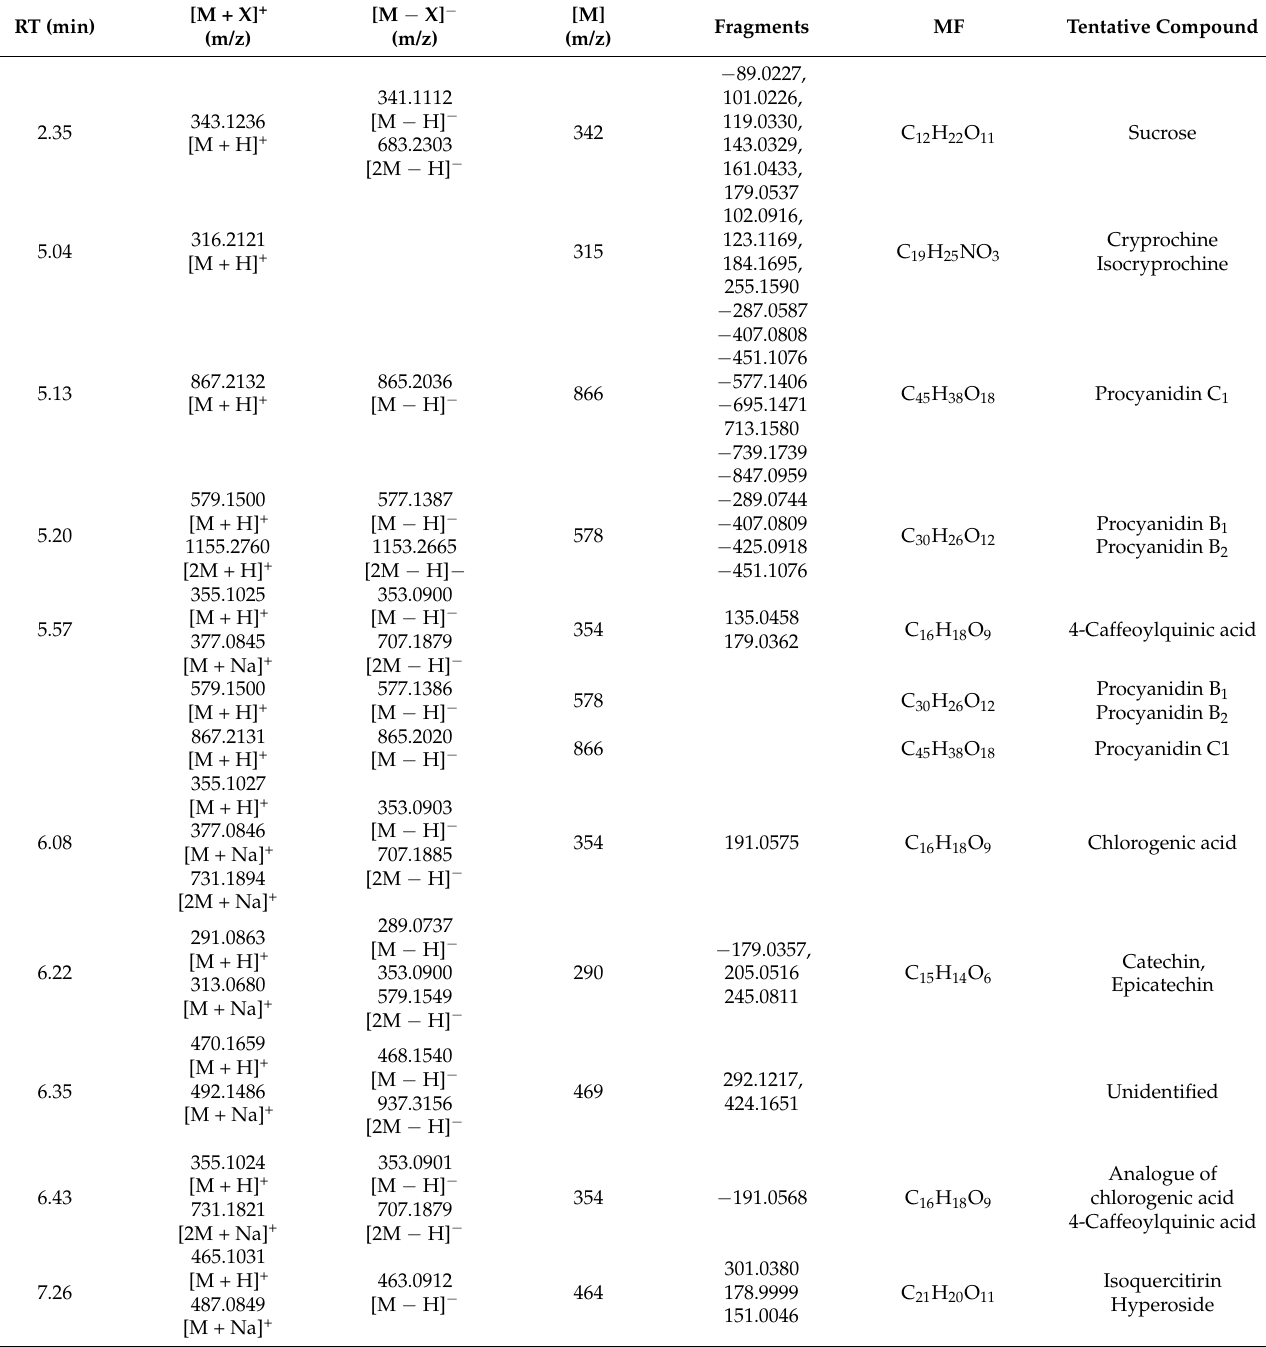
Table 3. Identification of compounds and antioxidant capacity from the methanol extract of peumo fruits, by LC-MS and MS/MS data. The principal peaks were individually analyzed, and the potential molecules were identified. Also, total polyphenol content (TPC), total flavonoid content (TFC), and antioxidant capacity by ORAC methods were determined. GAE, gallic acid equivalent; QE, quercetin equivalent; TE, trolox